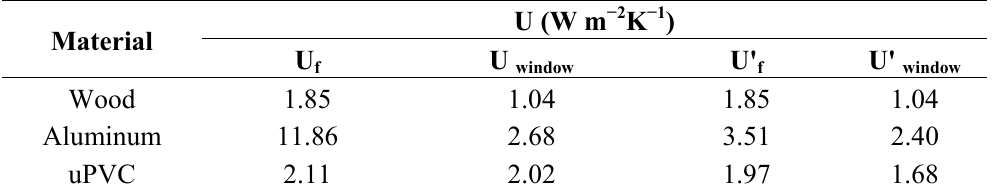
Table 2. Thermal performance of windows and frames using Therm (U’ refers to values when the frame was wooden but the casement materials